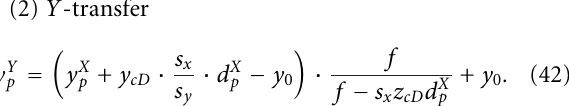
V V recti L and in recti R . These three types of info may or may not appear in